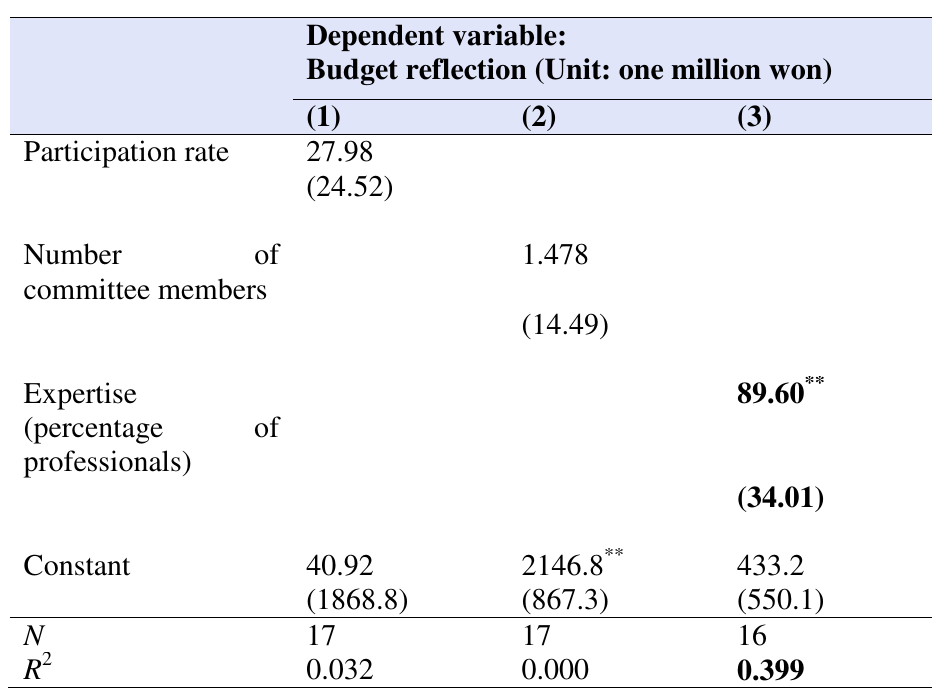
Table 2. Three independent variables and a regression analysis of the budget reflection (Subject: local governments of